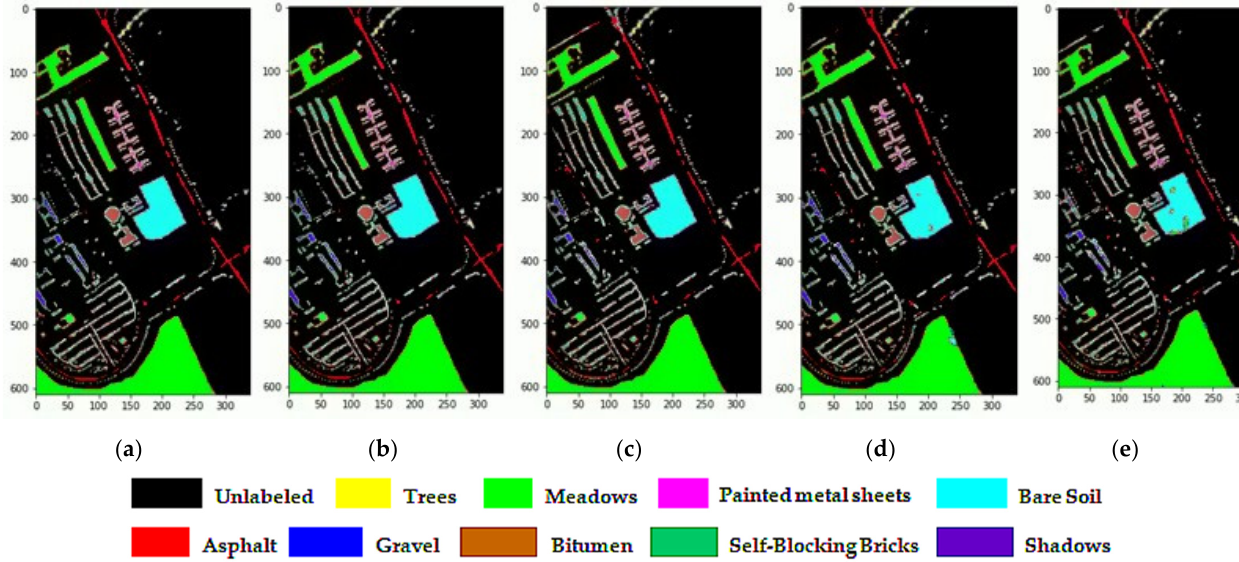
Figure 17. Classification maps of UP dataset: ( a ) Ground truth; ( b ) R-HybridSN; ( c ) HybridSN; ( d ) SSRN ( e ) HybridGBN-SR.